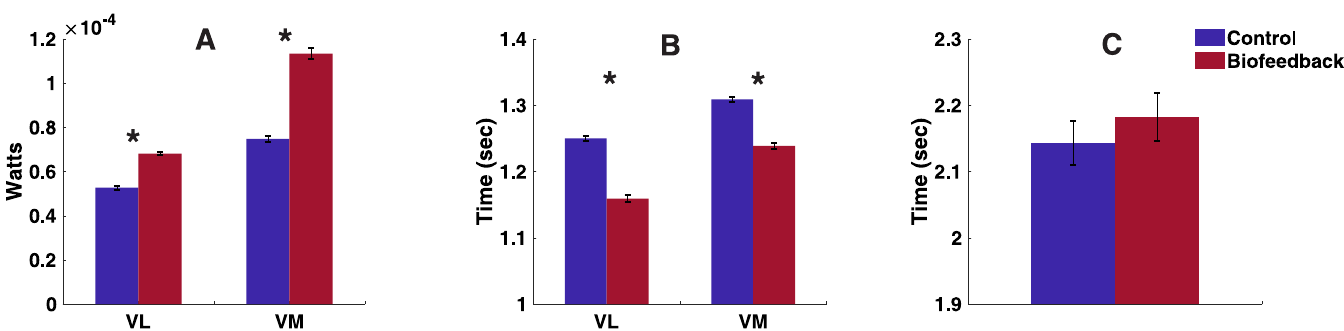
Fig 7. Mean ± SEM of (10 subjects, 6 trials, 90 contractions per trial): (A) EMG power (B) active time, and (C) time between peaks of EMG activation. The asterisk symbol ( � ) denotes statistical significance ( p < 0.05).